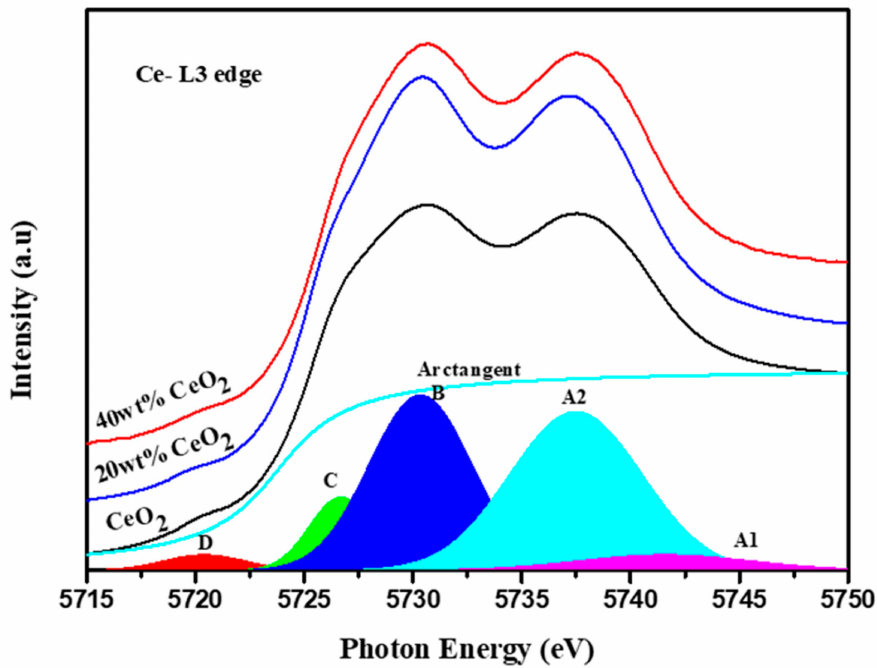
Figure 4. XANES of Ce L edge of CeO 2 , polymer composite with 20 wt% and 40 wt% CeO 2